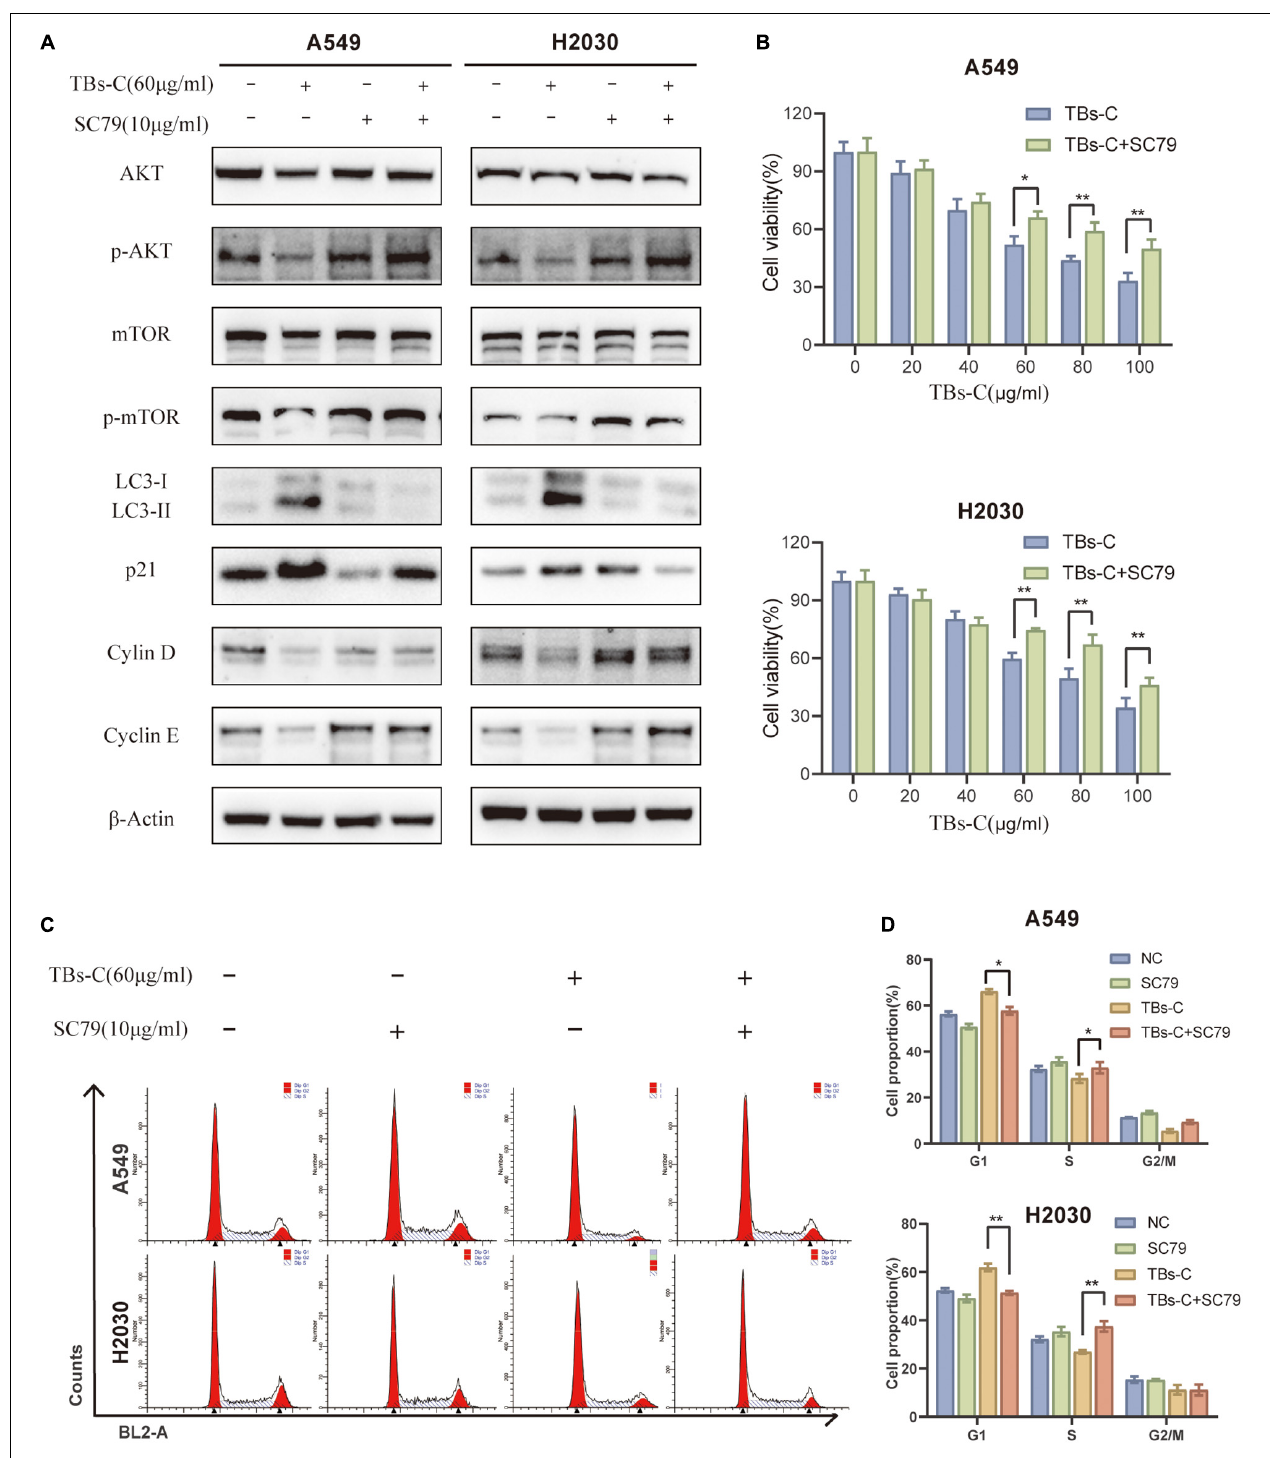
FIGURE 7 | TBs-C induces autophagy and the G1 cell-cycle arrest in NSCLC cells by inhibiting the PI3K/AKT/mTOR pathway. (A) The expression of AKT, p-AKT, mTOR, p-mTOR, p21, LC3, cyclin D, and cyclin E in the indicated cells was detected by Western blotting. (B) The cell viability of indicated cells were measured by the CCK-8 assay. (C) The cell cycle distribution of each group was determined by flow cytometry. (D) Analysis of cell cycle distribution by histogram, * p < 0.05, ** p < 0.01.